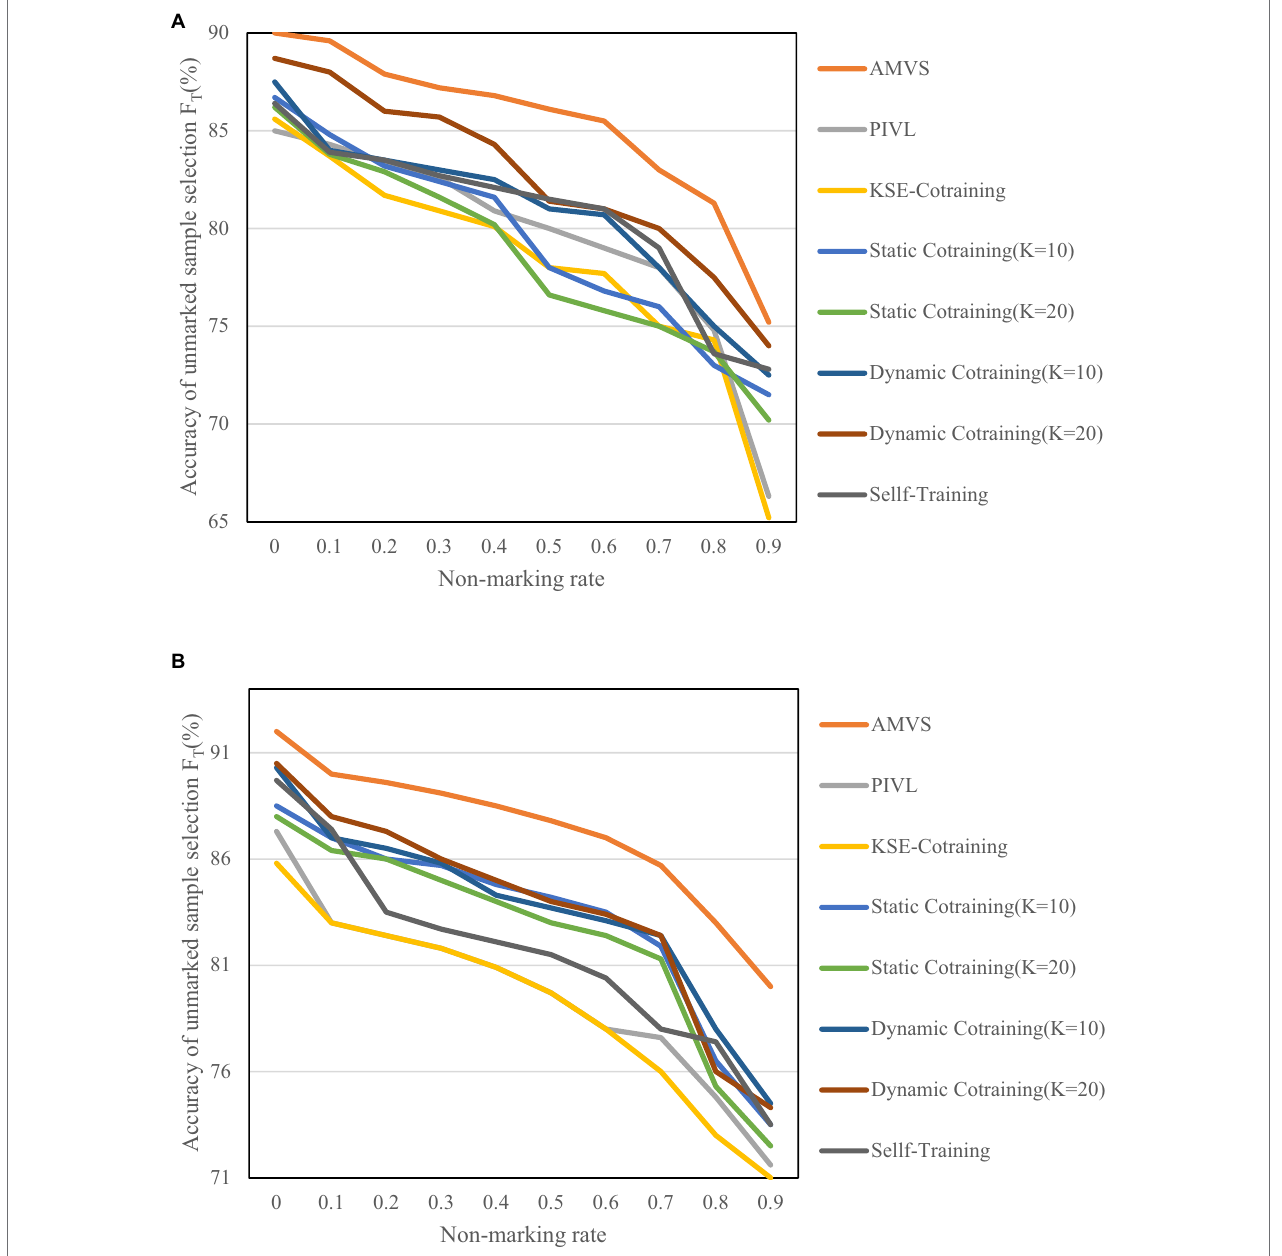
FIGURE 9 | Variation of unmarked sample selection accuracy F T at different unmarked rates. (A) Variation of F T when the base classifier is MNB. (B) Variation of F T when the base classifier is SVM.